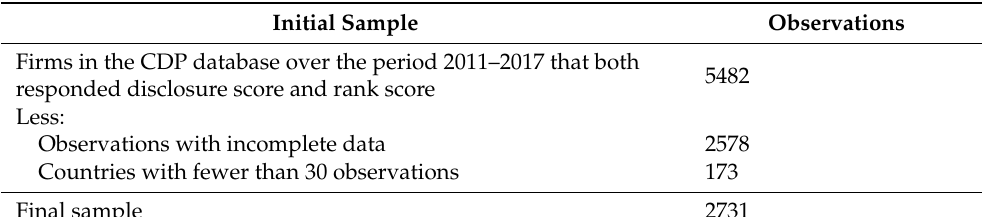
Table 1. Sample Selection Process. Initial Sample